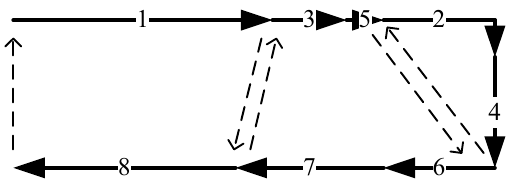
Figure 7. Real locations of all tasks for the example in Figure 5.